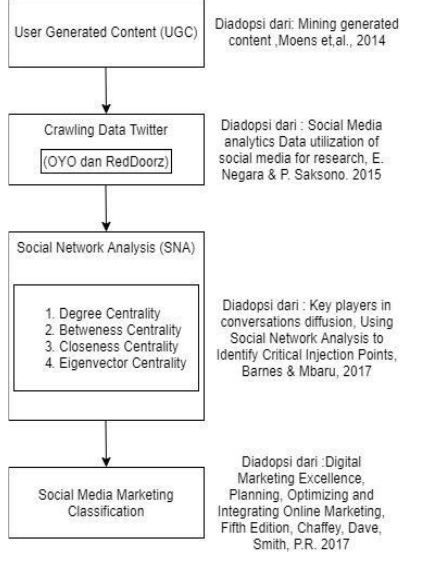
Figure 1: Research Framework